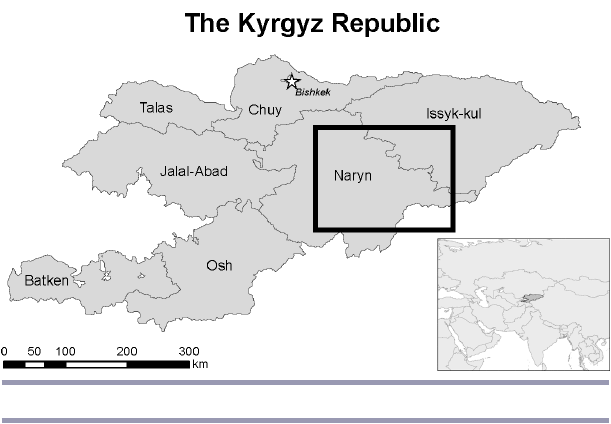
Fig. 1 . Kyrgyzstan and study region.